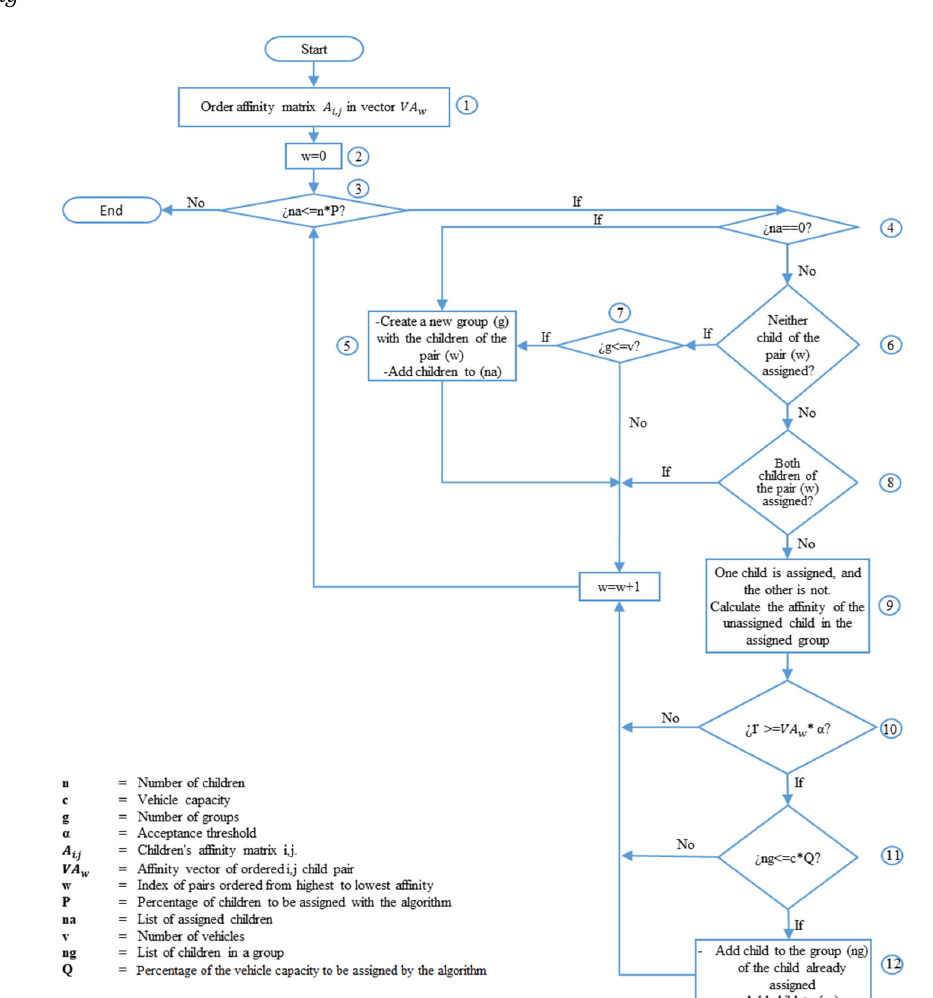
Fig. 5. Algorithm based on group technology for the assignment of children to